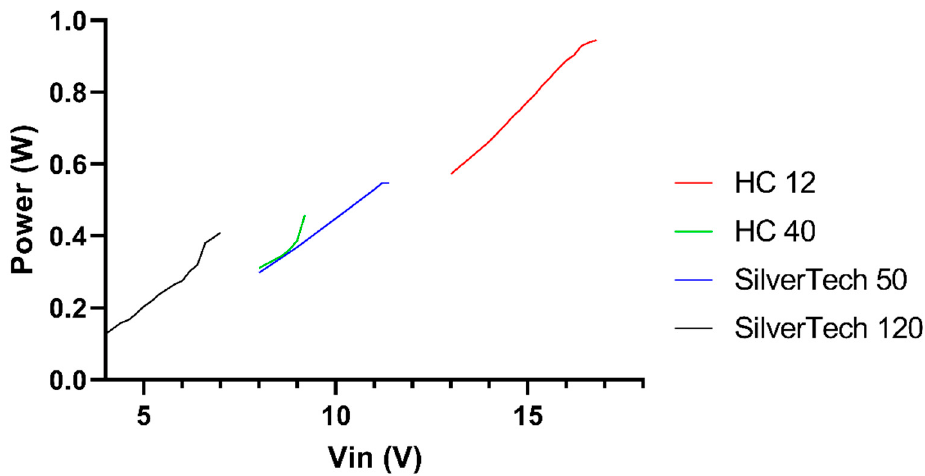
Figure 6. Average attained power per thread type for input voltage at the divider depicted in Figure